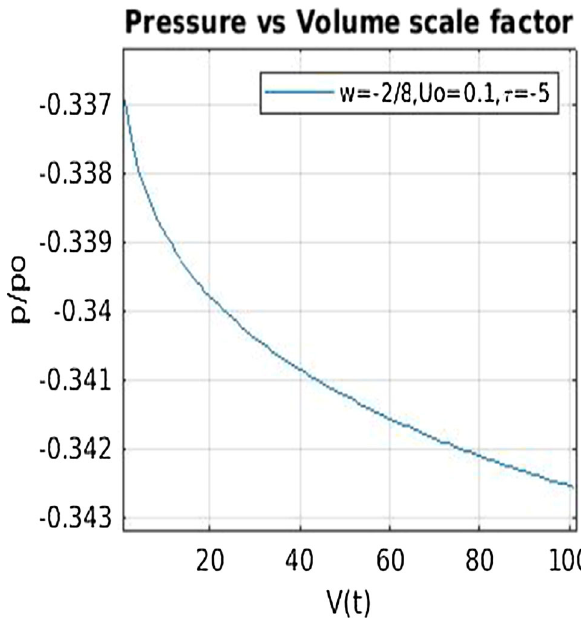
, U = 0 . 1 and τ = − 5 0 8